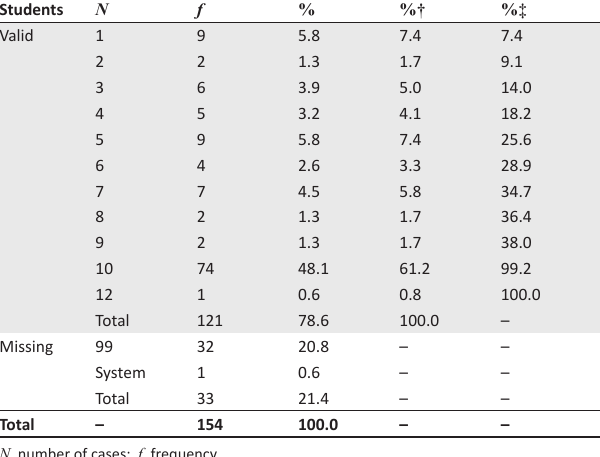
TABLE 6: Students’ performance on dual antiretroviral therapy. Students